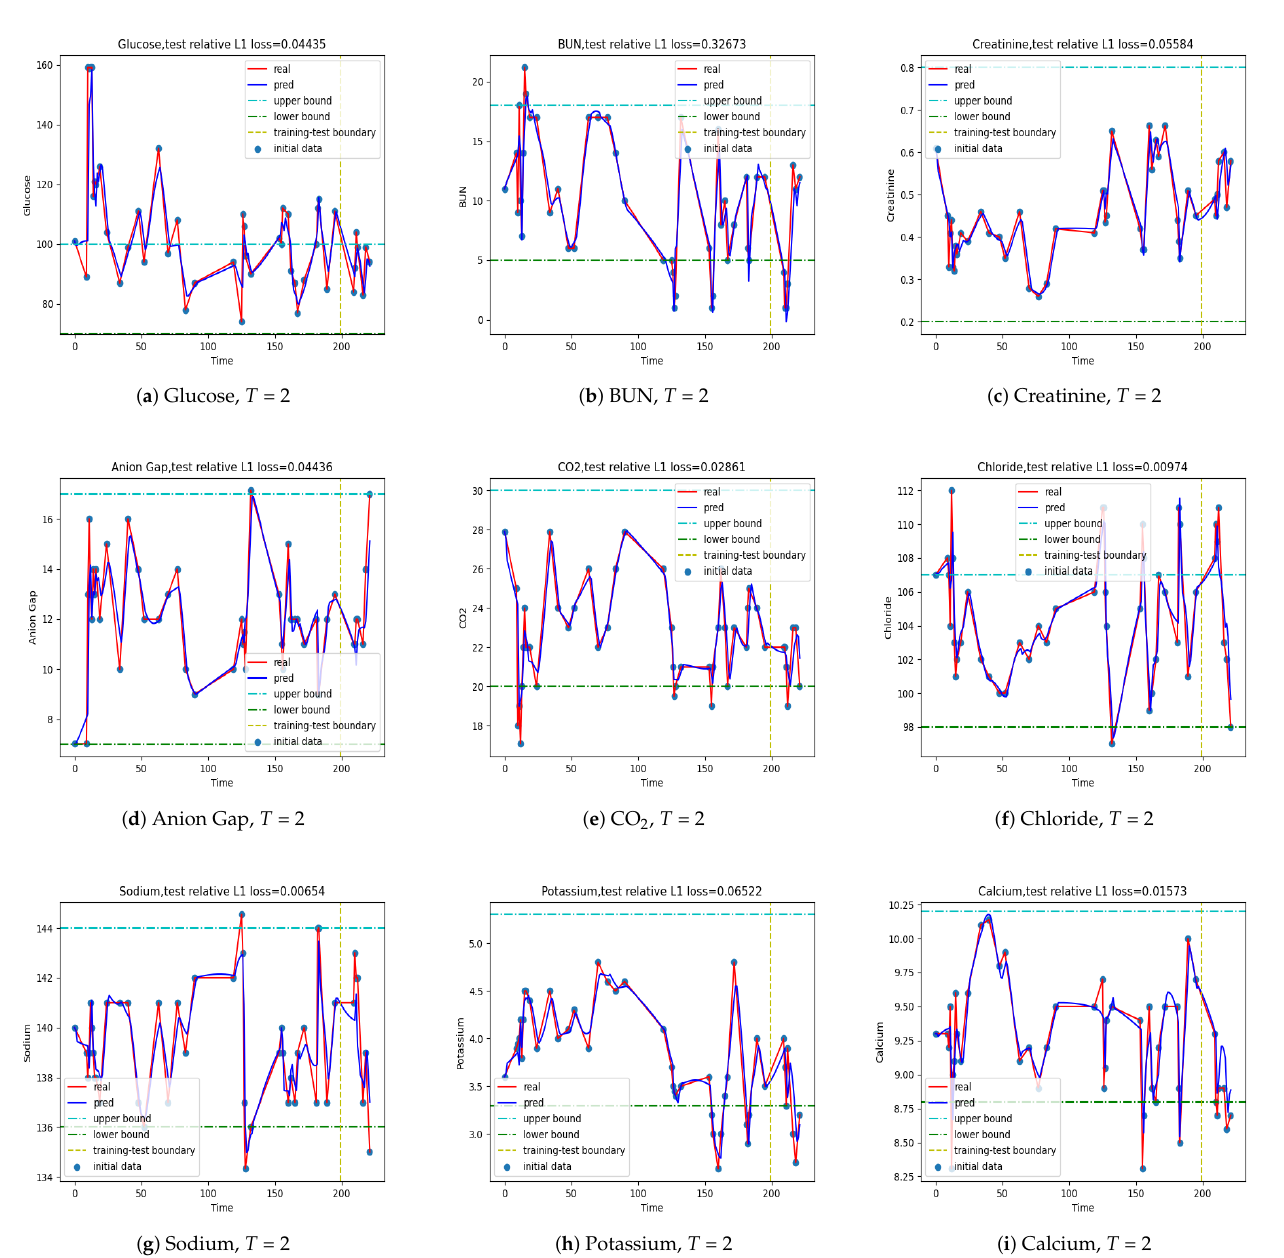
Figure A1. The one-step prediction of the LSTM model for patient MS with time step T =